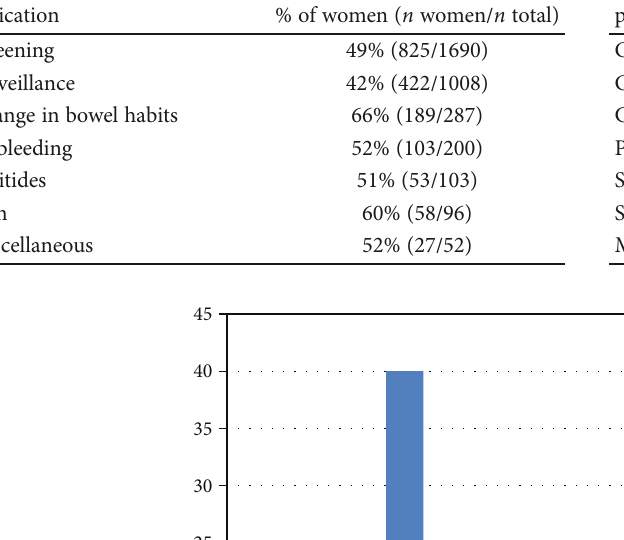
Table 4: Colonoscopy intervals by colonoscopy indication. Indication (% of patients with Interval (years) (+SD) between prior colonoscopy on record) last and current colonoscopy Change in bowel habits (28.1%)